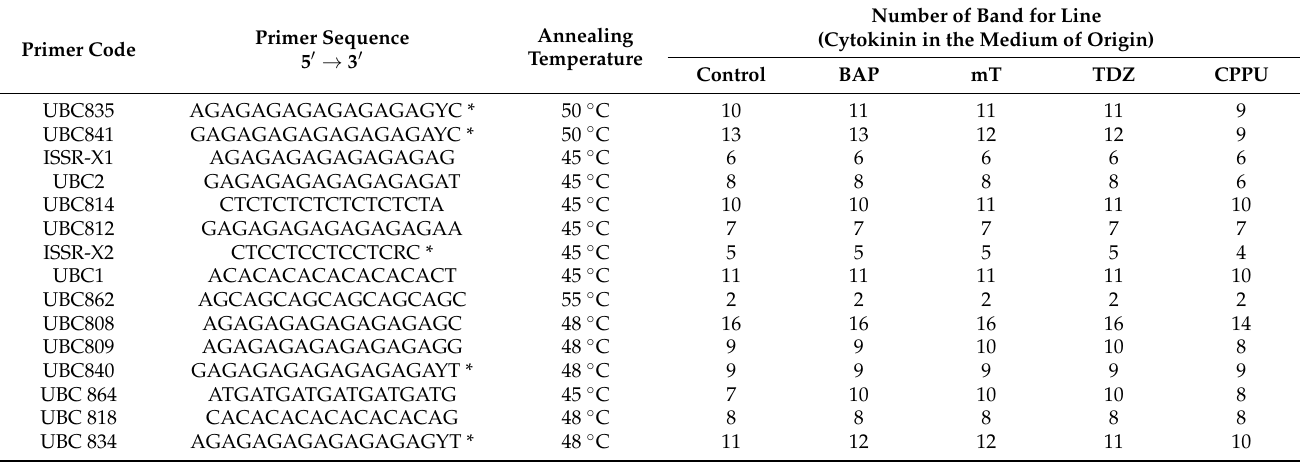
Table 1. Primers used in ISSR-PCR analysis of S. bulleyana shoot